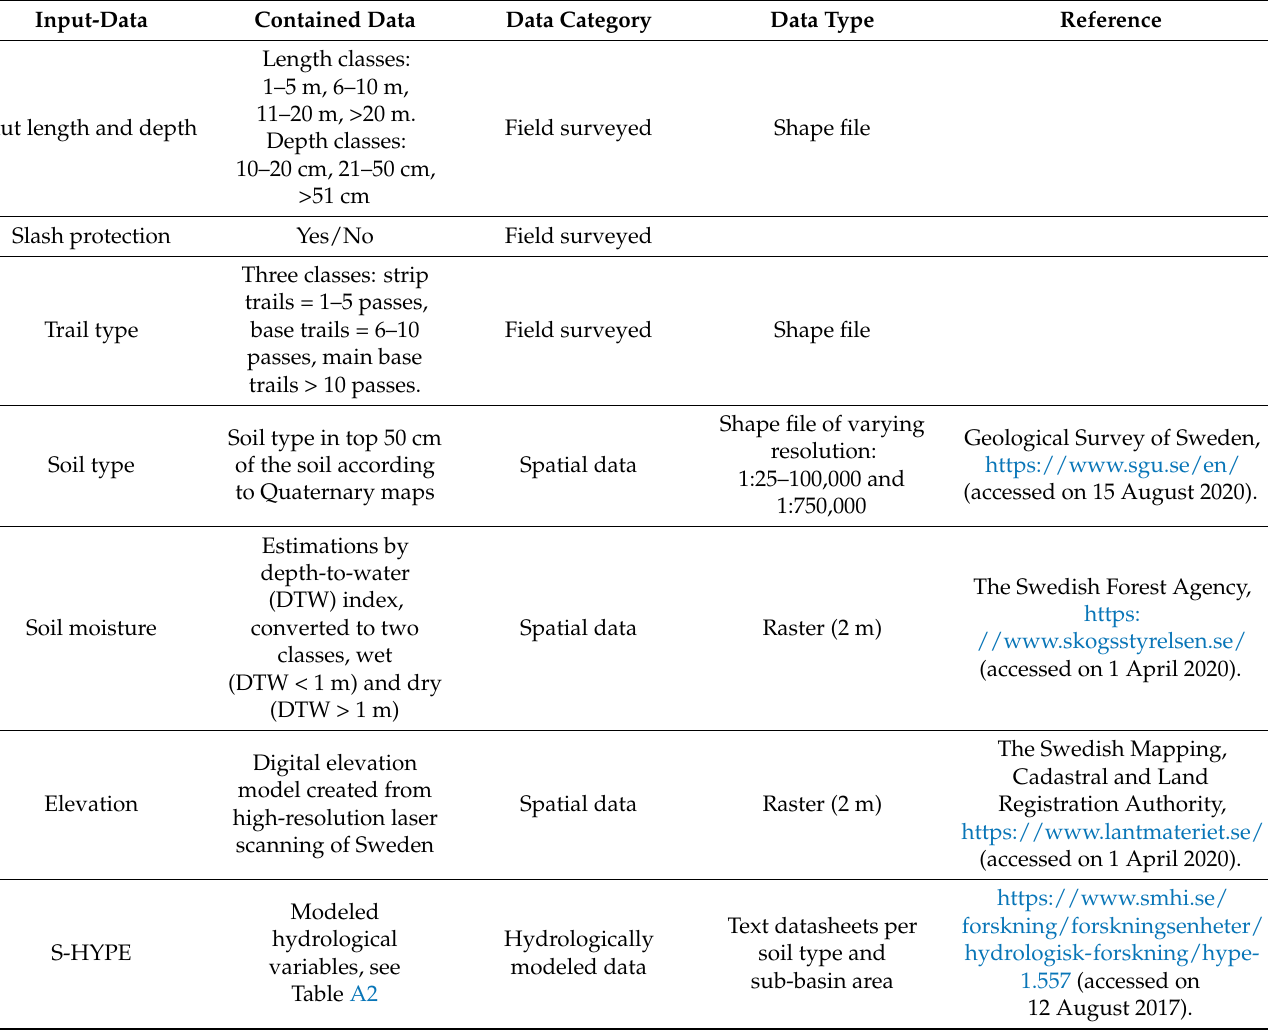
Table 1. Summary of input data used in this study: field-surveyed, spatial, and